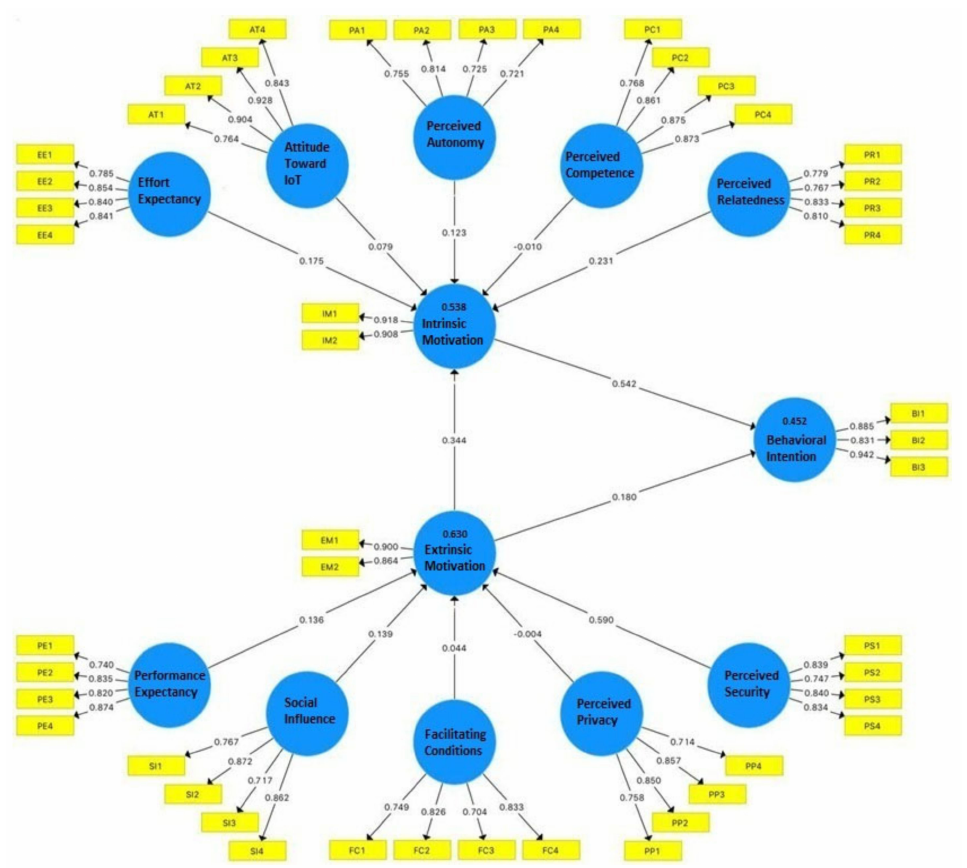
Figure 3. Partial least squares (PLS) algorithm